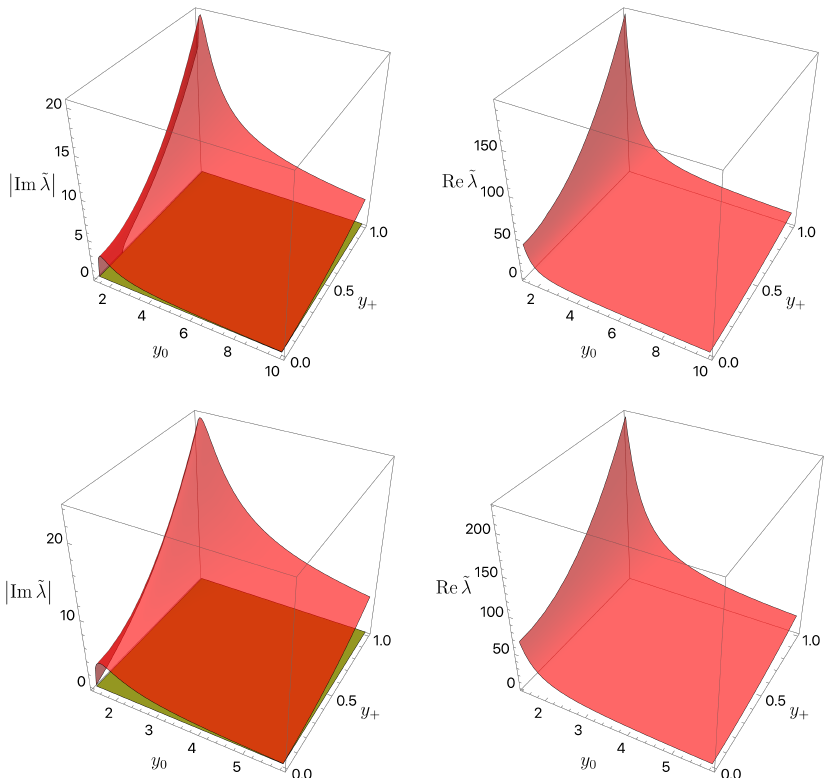
Figure 6 . The absolute value of the imaginary part (left column) and the real part (right column) of the first complex excited mode in a region of y 0 and y the scales are very different in the left and right figures. The top row has d “ 4, while the bottom row has d “ 5. The green horizontal plane on the left column sits at aid